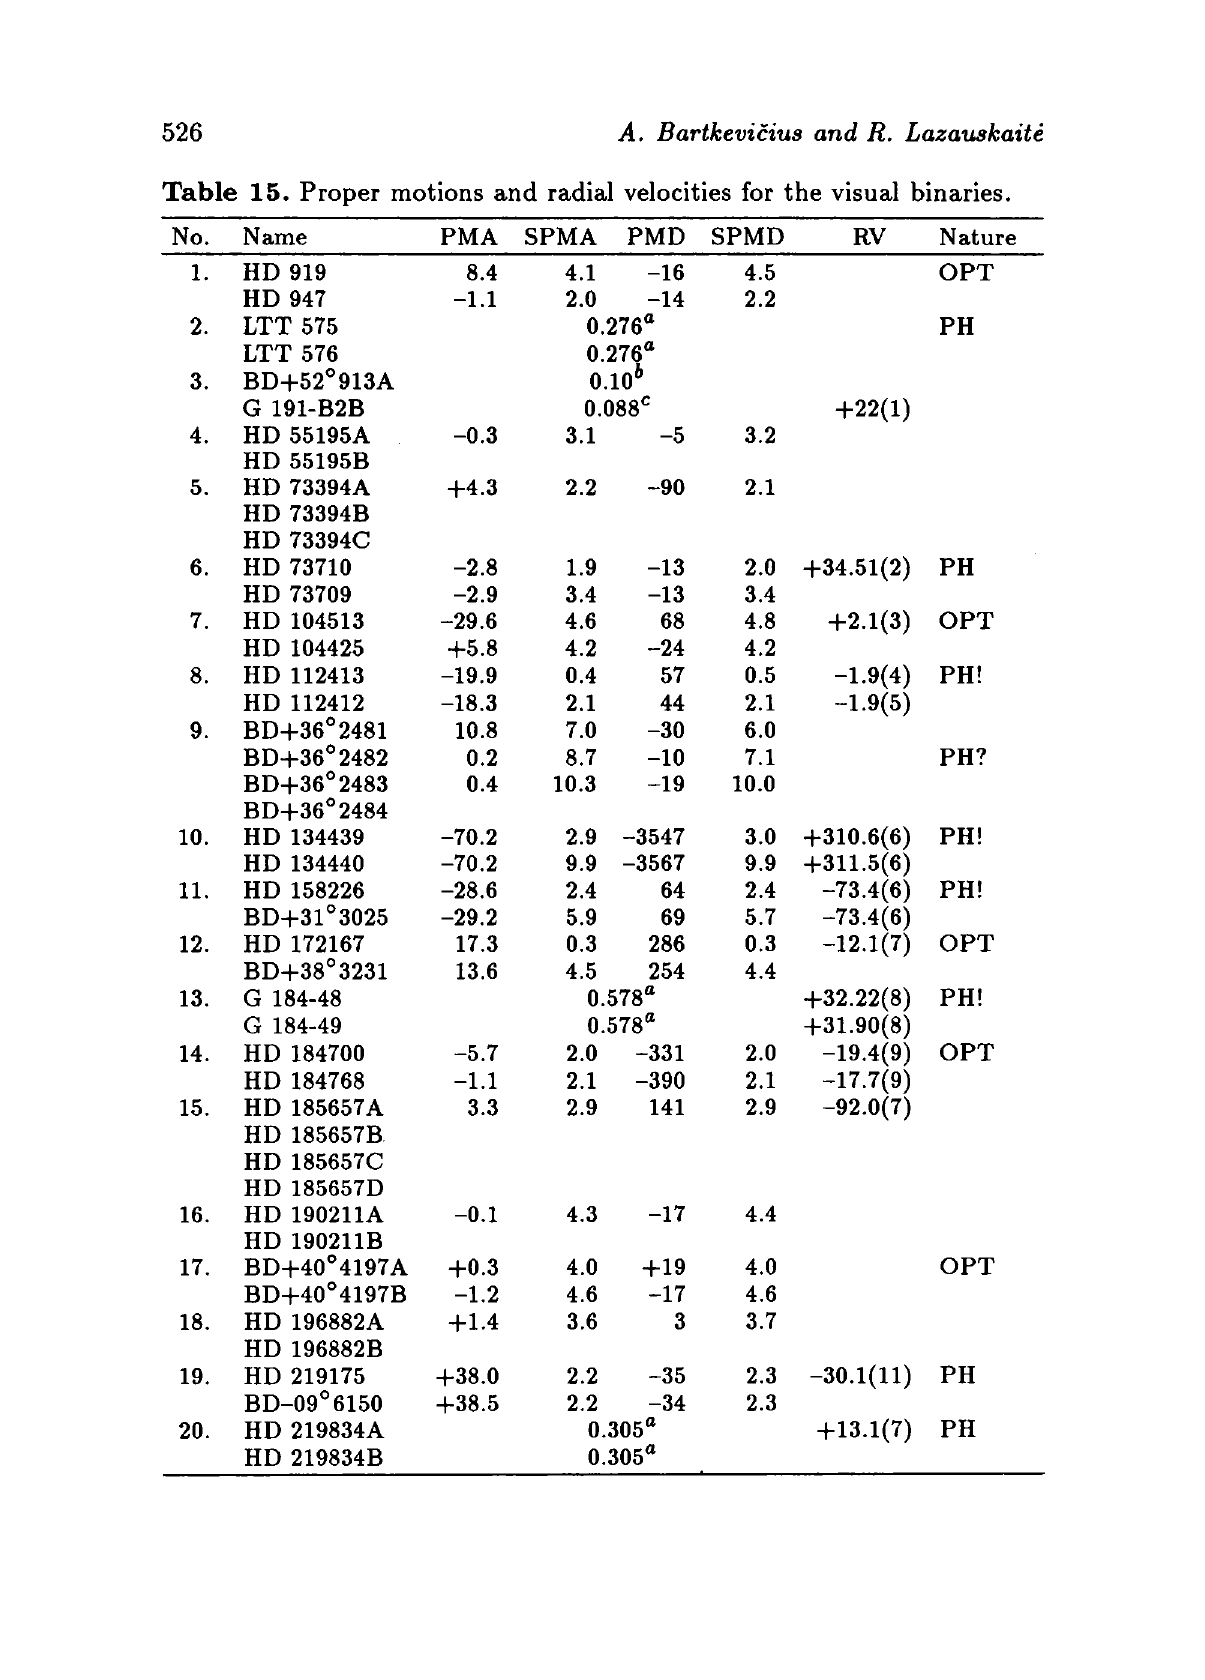
Table 15. Proper motions and radial velocities for the visual